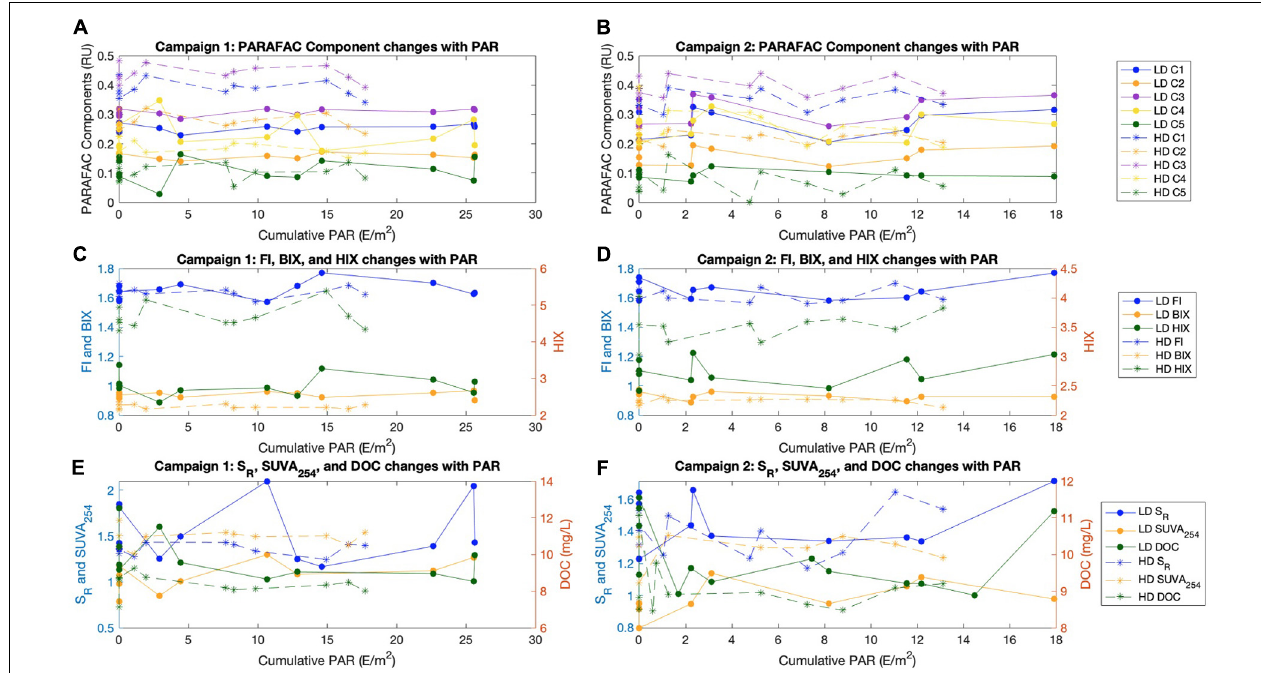
FIGURE 2 | All indices and PARAFAC components plotted against cumulative PAR (E/m 2 ) for the diel study, separated between Campaign 1 (Left) and Campaign 2 (Right), as well as by site (LD circles and lines, HD asterisk and dashed). (A,B) PARAFAC components in Raman units (RU). (C,D) FI and BIX on the left axis, HIX on the right axis. (E,F) S R and SUVA 254 on the left axis and DOC (mg/L) on the right